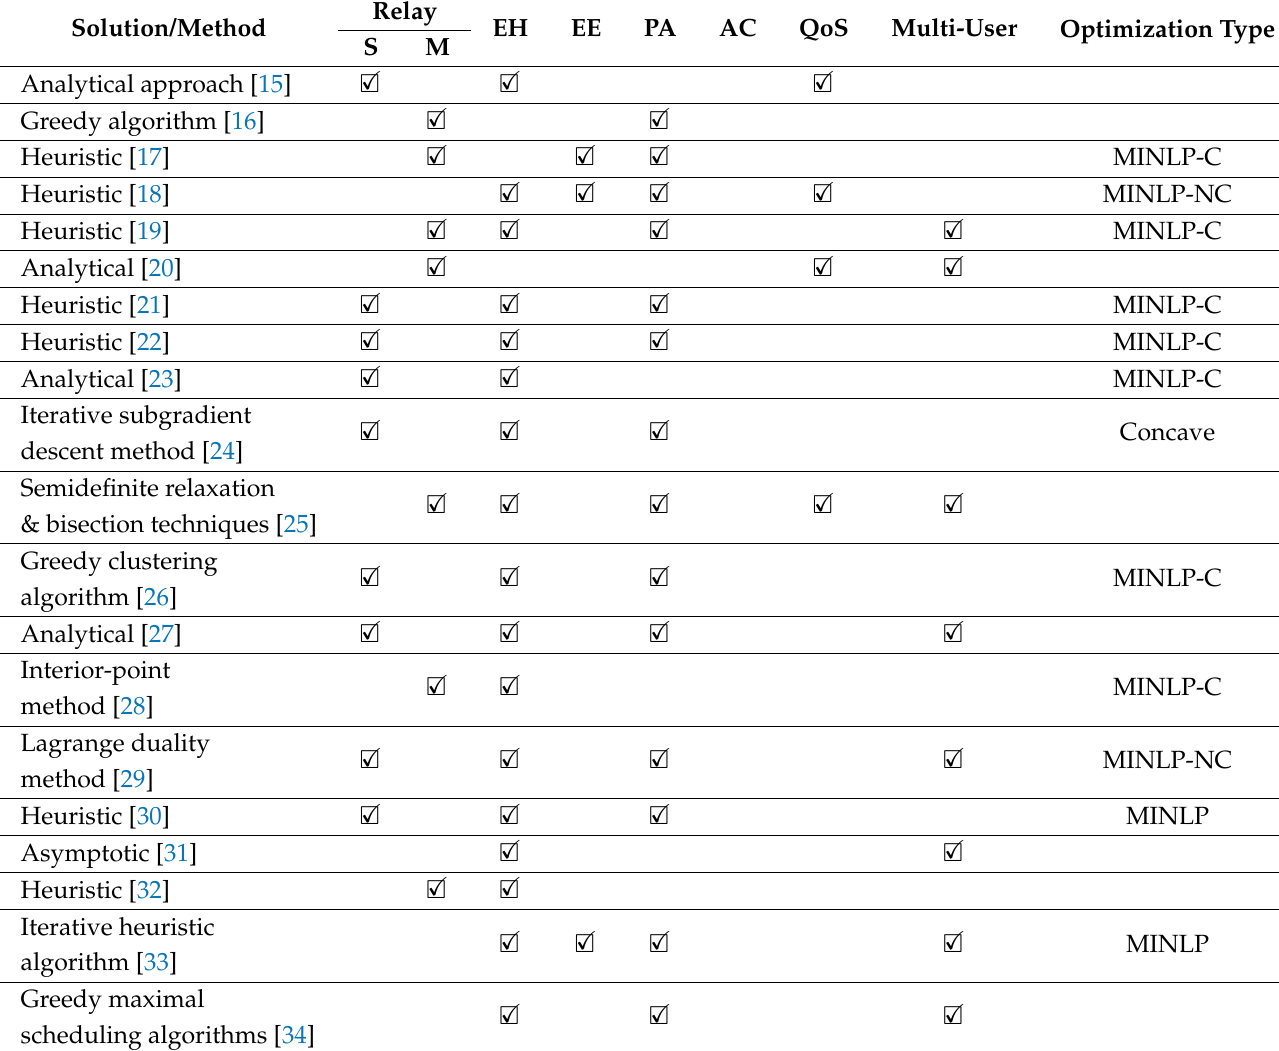
Table 1. State of the art literature of resource management in IoT-Networks with 5G/B5G communication in energy harvesting cooperative networks; where Single relay (S), as well as Multiple relays (M), are considered, here, EH: Energy Harvesting, EE: Energy Efficiency, PA: Power Allocation, AC: Admission Control, QoS: Quality of Service. Solution/Method Optimization Type